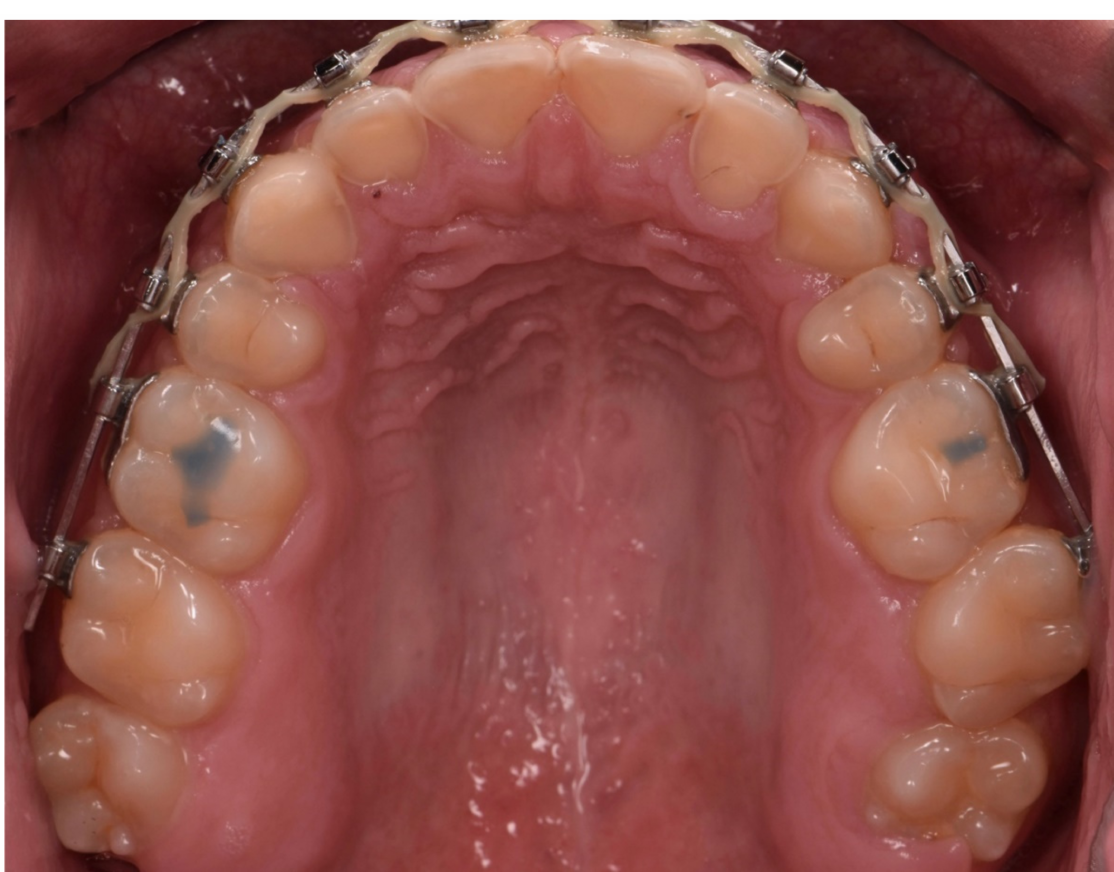
Figure 8. Intraoral occlusal picture (upper